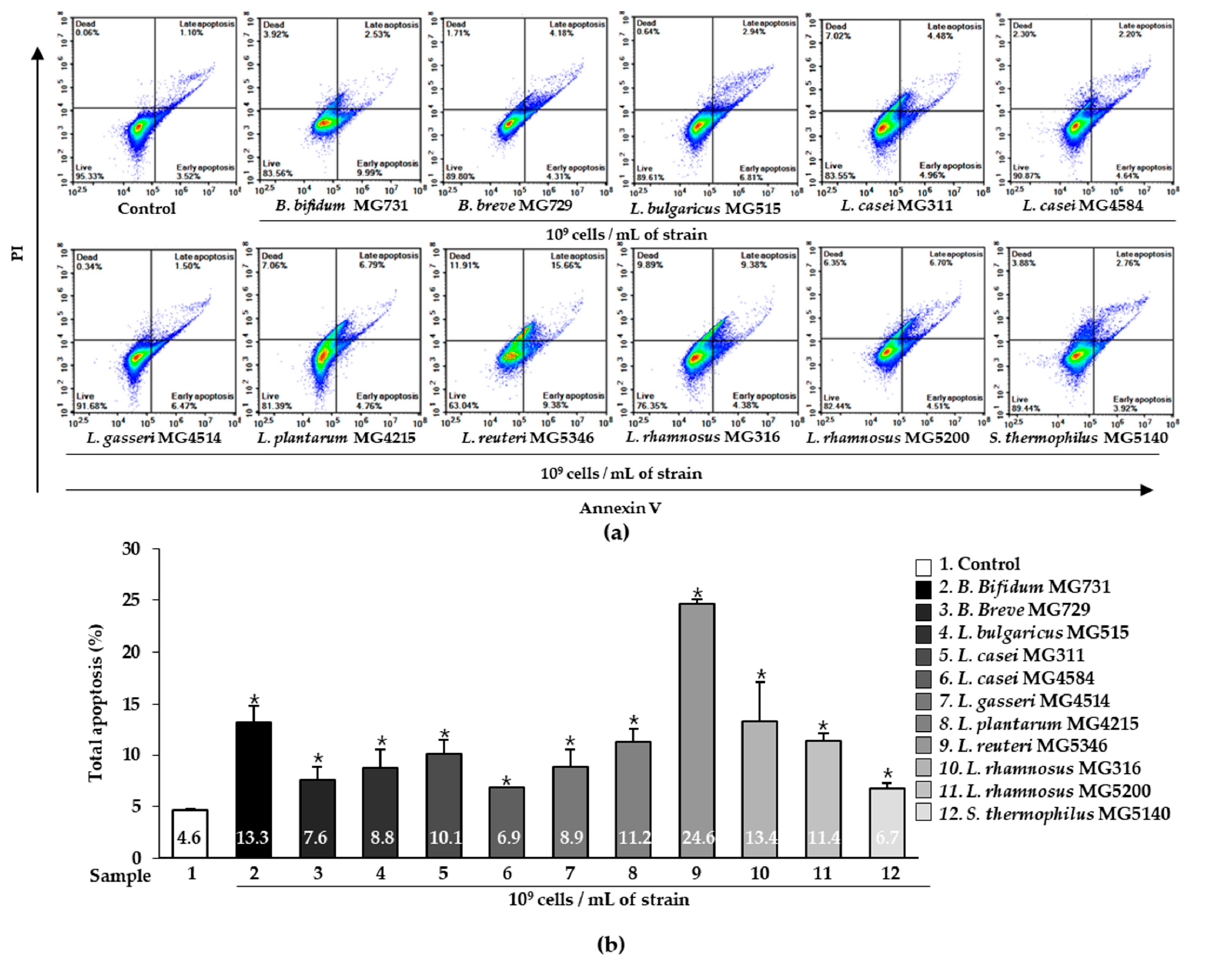
Figure 2. Apoptosis of heat-killed Bifidobacterium and Lactobacillus in human gastric cancer MKN1 cells analyzed by flow cytometry assay. ( a ) Representative Annexin V and PI staining for apoptosis and ( b ) total apoptosis (%) in MKN1 cells. Results are presented as mean ± SD in three independent experiments. * p < 0.05 compared with the control.